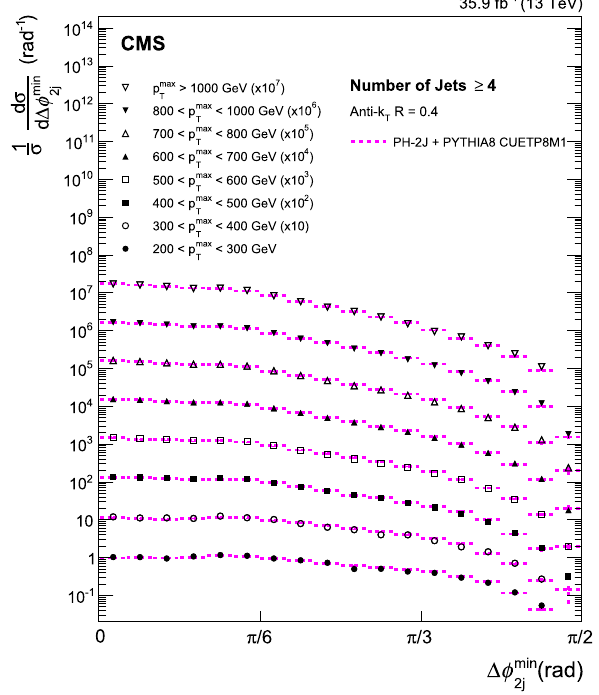
Fig. 11 Normalized inclusive 4-jet cross section differential in Δφ min for eight p max regions, scaled by multiplicative factors for presentation T purposes. The size of the data symbol includes both statistical and sys- tematic uncertainties. The data points are overlaid with the predictions from the ph- 2j + pythia 8 event